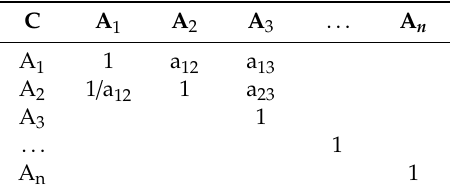
Table 2. Fuzzy comparison